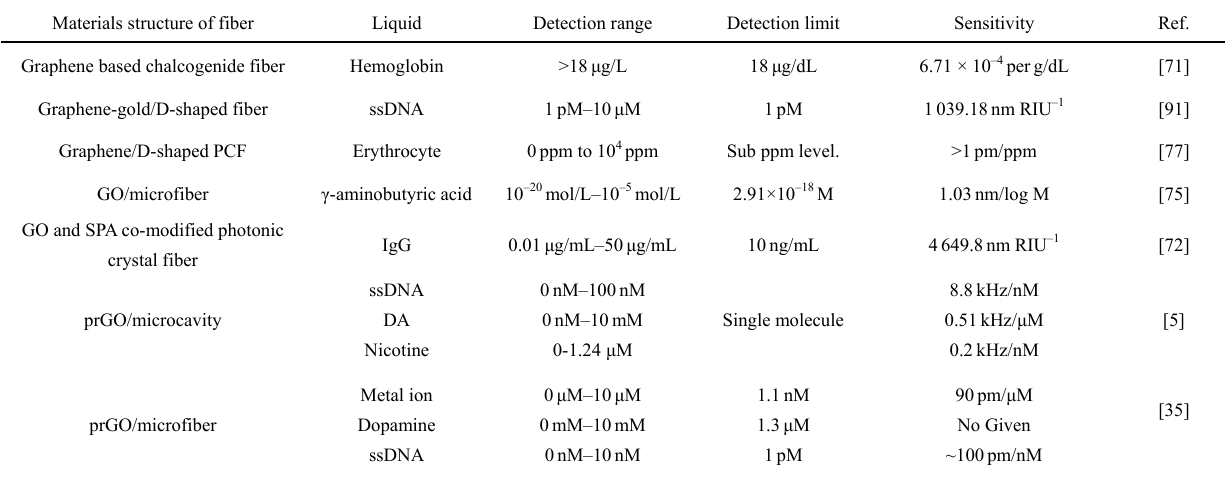
Table 2 Summary of sensing performances for